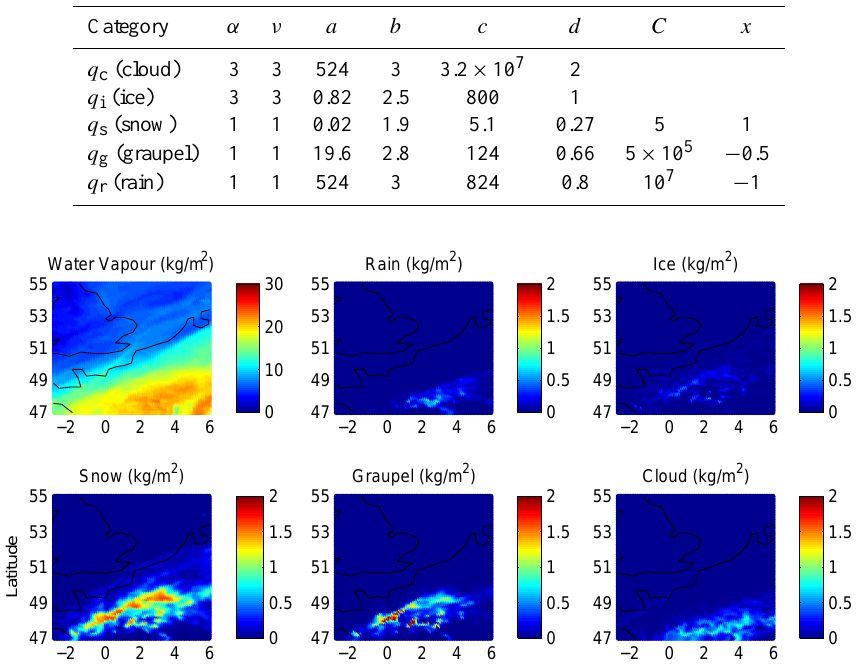
Figure 1. The Meso-NH fields at 13:00UTC of the heavy snowfall scene over France on 8 December 2010. Coincident observations from MHS and CloudSat are